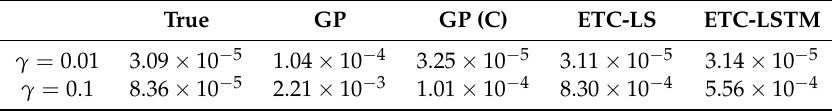
Table 1. Root mean squared error (RMSE) between the FOM vorticity field and the vorticity field predicted with the true, GP, GP (C), ETC-LS, and ETC-LSTM framework at time t = 20 with R = 8 basis